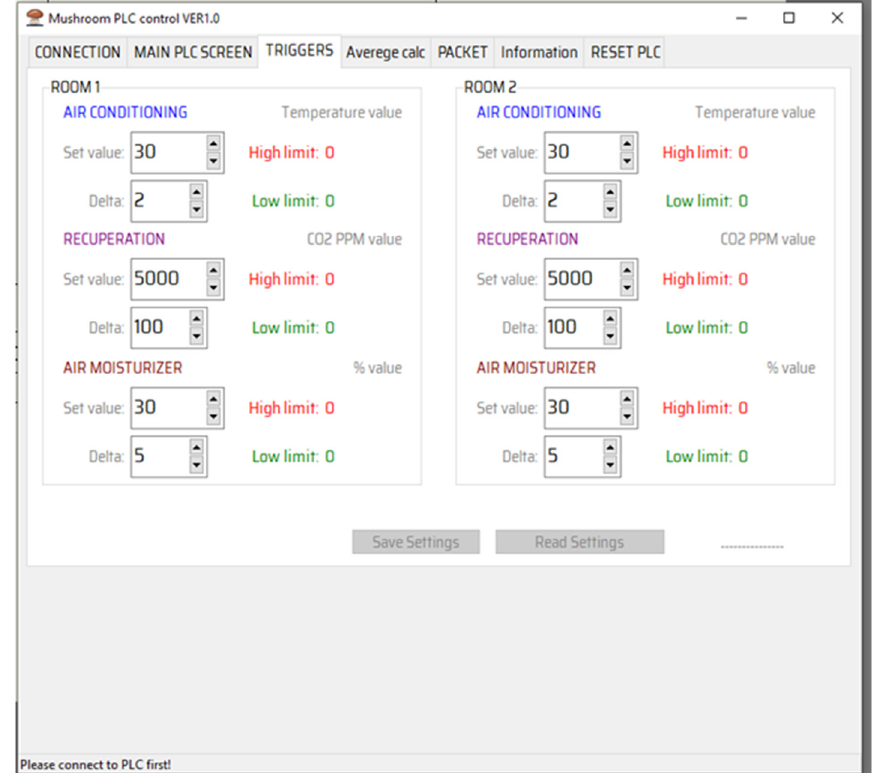
Figure 9. Values of parameters in the control application of mushroom cultivation conditions.